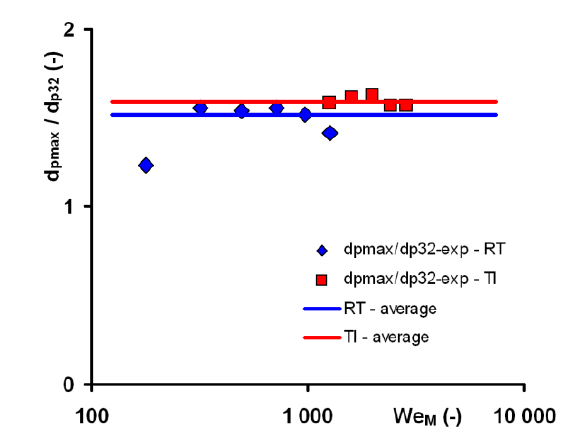
Fig. 10. Dimensionless correlation d pmax / d p32 . Fig. 11. Dimensionless breaking-rate constant vs. Weber